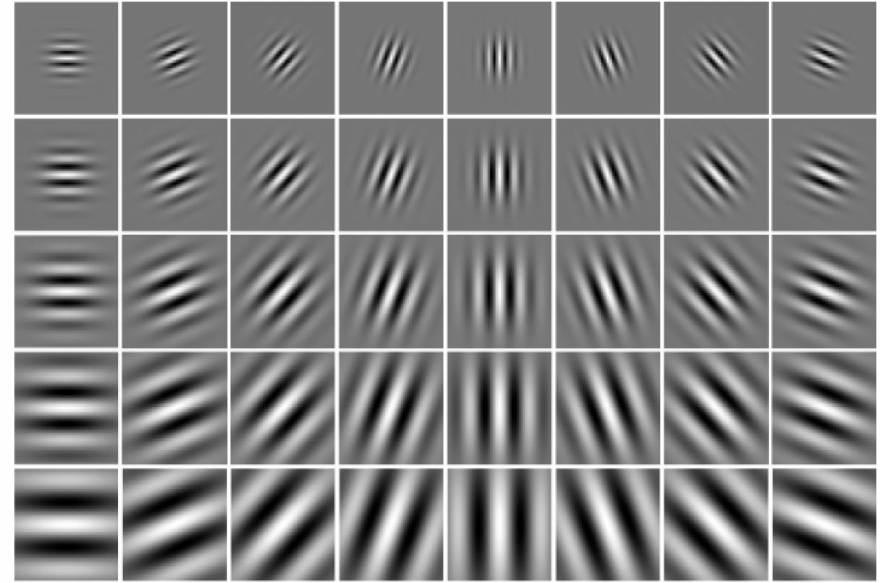
Figure 3. The 40 Gaussian filters in the Gabor filter.